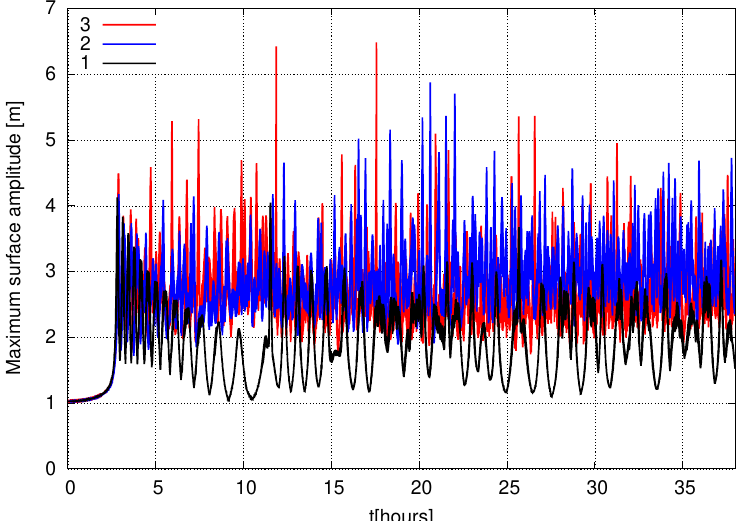
Figure 14. Dependence of maximum surface amplitude on time in three different nonlinear models at µ = 0.04 and ˜ k p = 1. Black solid curve 1 corresponds to the NLS model, blue solid curve 2—to the SCZ equation and red solid curve 3—to the RV